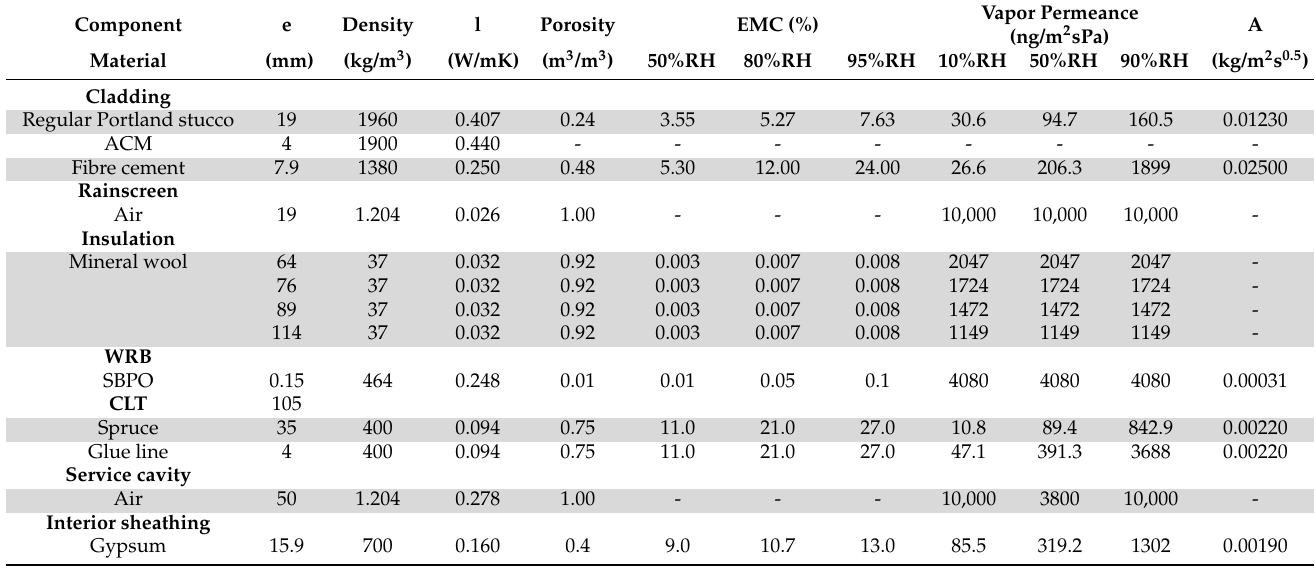
Table 2. Basic properties of materials